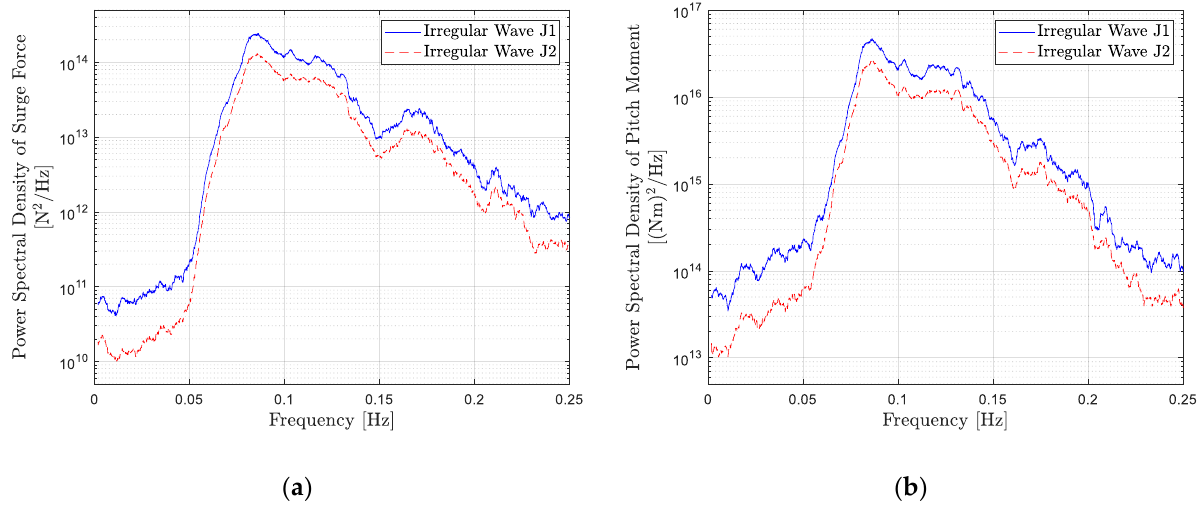
Figure 14. Power spectral densities of full-scale ( a ) surge force and ( b ) pitch moment on the upstream column of Configura- tion P in irregular waves J1 and